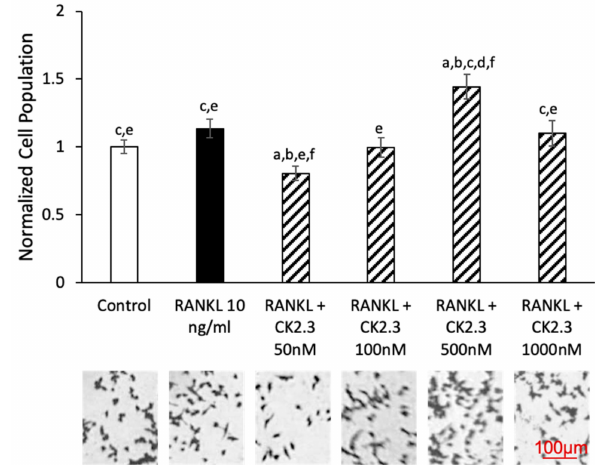
Figure 2. E ff ect of CK2.3 on RAW264.7 cell growth. RAW264.7 cells were stimulated with di ff erent concentrations of CK2.3 for 5 days. Cell growth was a ff ected by CK2.3 at 50 nM and 500 nM. However, it was not a ff ected at 100 nM and 1000 nM. a: denotes significant di ff erences from Control, b: denotes significant di ff erence from RANKL at 10 ng / mL, c: denotes significant di ff erence from RANKL + CK2.3 at 50 nM, d: denotes significant di ff erence from RANKL + CK2.3 at 100 nM, e: denotes significant di ff erence from RANKL + CK2.3 at 500 nM, and f: denotes significant di ff erence from RANKL + CK2.3 at 1000